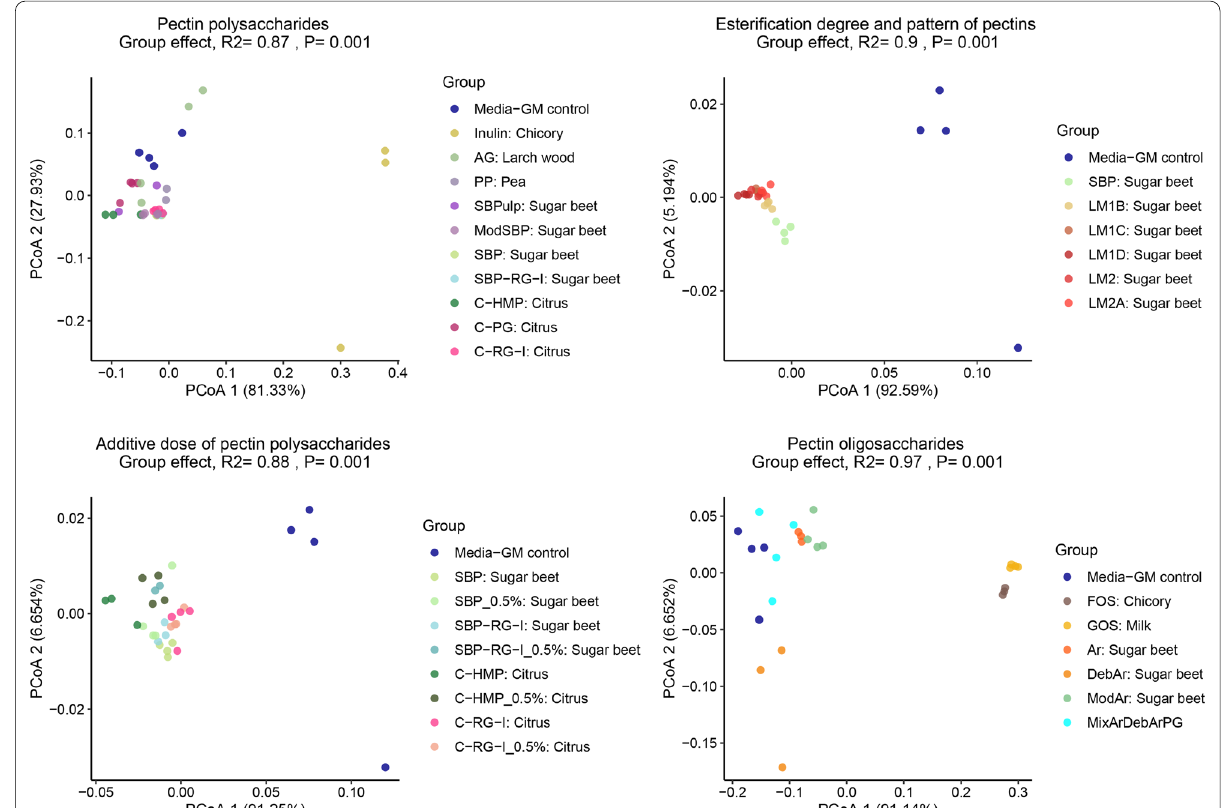
Fig. 3 The effect of different substrates on in vitro simulated piglet gut microbiota as determined by 16S rRNA gene (V3-region) amplicon sequencing (Weighted Unifrac distance metrics). All fermentations were carried out in quadruplicate (with exceptions as stated in Fig. 1). a Polysaccharides sourced from pectins with inulin and AG (arabinogalactan) as prebiotic controls. b Sugar beet pectins with different degrees and patterns of esterification. c Different pectin polysaccharides at additive dose of 1% and 0.5%. d Oligossaccharides derived from pectins with FOS (fructooligosaccharides) and GOS (galactooligosaccharides) as prebiotic controls. See Table 1 substrate abbreviations and details on degree of esterification and acetylation for the different